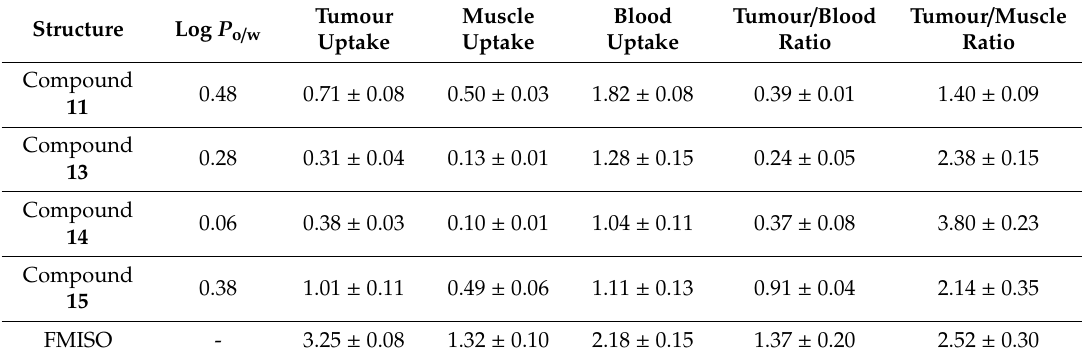
Table 3. Comparison of “in vitro” and “in vivo” uptake of 2-nitroimidazolic [ 99m Tc]Tc-tricarbonyl complexes bearing the same pharmacophore and linker and di ff erent donor atoms sets. (Biodistribution values are expressed in %D / g ± SD ( n = 3) at 1 h in Swiss mice with fibrosarcoma). Tumour Muscle Structure Log P o / w Uptake Uptake Uptake